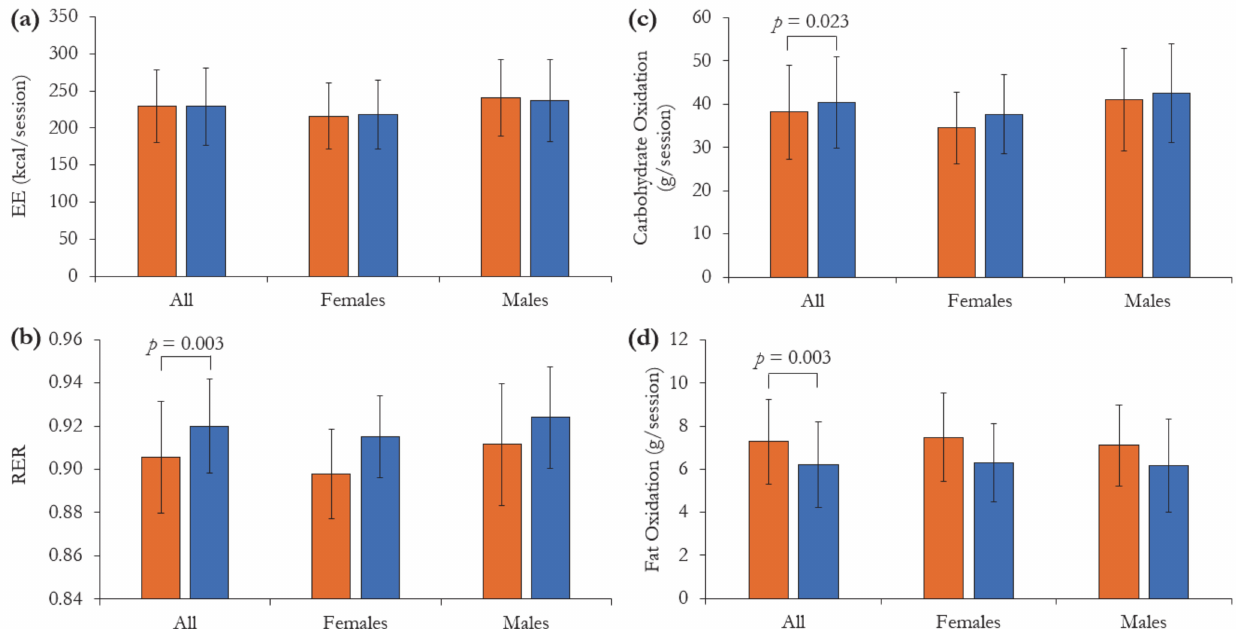
Figure 3. ( a ) Energy expenditure (EE), ( b ) respiratory exchange ratio (RER), ( c ) carbohydrate oxidation and ( d ) fat oxidation, during the exercise session following the consumption of the isocaloric high-protein meal replacement (HP-MR) and control (CON) breakfasts while participants were inside the whole-body calorimetry unit. Values are mean ± standard deviation. n = 43 (females n = 19; males n = 24). p -values represent significant difference between the HP-MR and CON groups, as assessed by mixed analysis of